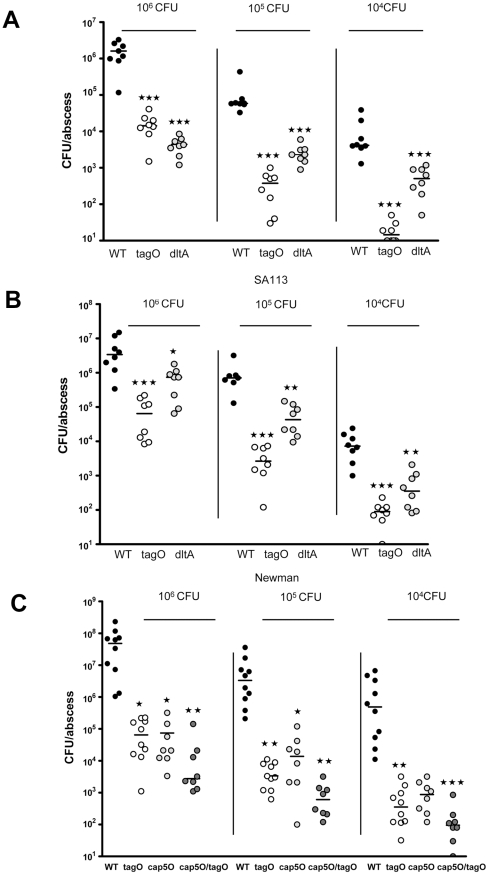
Strains with no WTA or structurally altered WTA are deficient in induction of s.c. abscesses.106 to 104 CFU S. aureus was injected s.c into the flanks of mice. After 48 h, the mice were euthanized, and each abscess was excised, homogenized, and cultured quantitatively. Horizontal bars represent group median values, n = 8. A) The Sa113dltA mutant (negatively charged teichoic acids) and the tagO mutant (no WTA) were attenuated compared to the wt (all p-values are 0.0002). B) Newman tagO (p = 0.0002 at 106; p = 0.0003 at 105, p = 0.0002 at 104) and the dltA mutant (p = 0.0047 at 106; p = 0.0006 at 105, p = 0.007 at 104) were significantly less virulent in the abscess model compared to the wt, n = 8. All p-values were determined by Mann-Whitney analysis. C) Newman wt, tagO, isogenic acapsular mutant cap5O and the cap5O/tagO double mutant were grown on CSA plates to enhance CP production. The Newman tagO (p<0.05 at 106; p<0.01 at 105, p<0.01 at 104) and cap5O (p<0.01 at 106; p<0.05 at 105, p>0.05 at 104) mutants and the double mutant (p<0.001 at 106; p<0.001 at 105, p<0.001 at 104) were significantly inhibited in abscess formation compared to the wt. The mutants showed no significant difference when compared to each other. P-values for Figure 2C were determined by Kruskal-Wallis one-way ANOVA with Dunn's multiple comparison test. ★
p<0.05;
★★
p<0.01, ★★★
p<0.001.